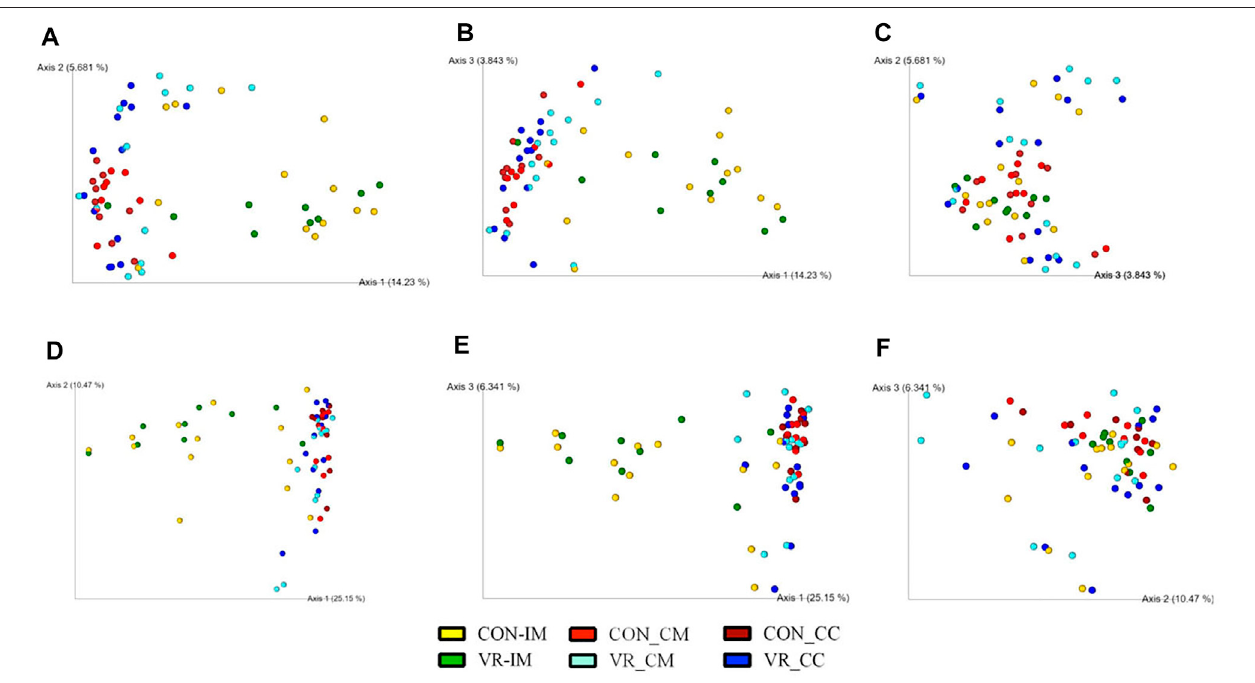
FIGURE 7 | Beta diversity plots of ceca microbiome from CON and VR birds ( n = 15/group) via weighted Bray-Curtis (A – C) and Jaccard (D – F) PCoA plots. Each sphererepresentsintestinalsitefromanindividualbird,coloredperrespectivegroup.FiguresweregeneratedbyQIIME2software.Yellow,CONileummucus.Green,VR ileum mucus. Bright red, CON ceca mucus. Bright blue, VR ceca mucus. Dark red, CON ceca content. Dark blue, VR ceca